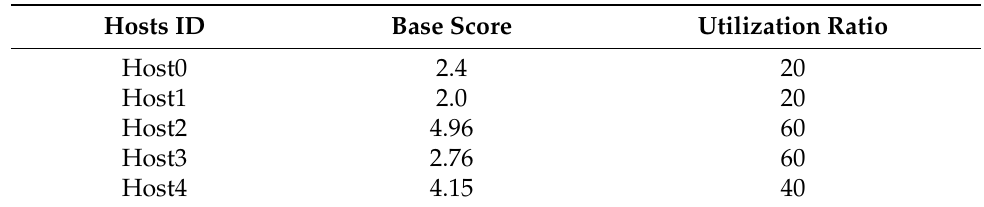
Table 6. Hosts CVSS base score and utilization